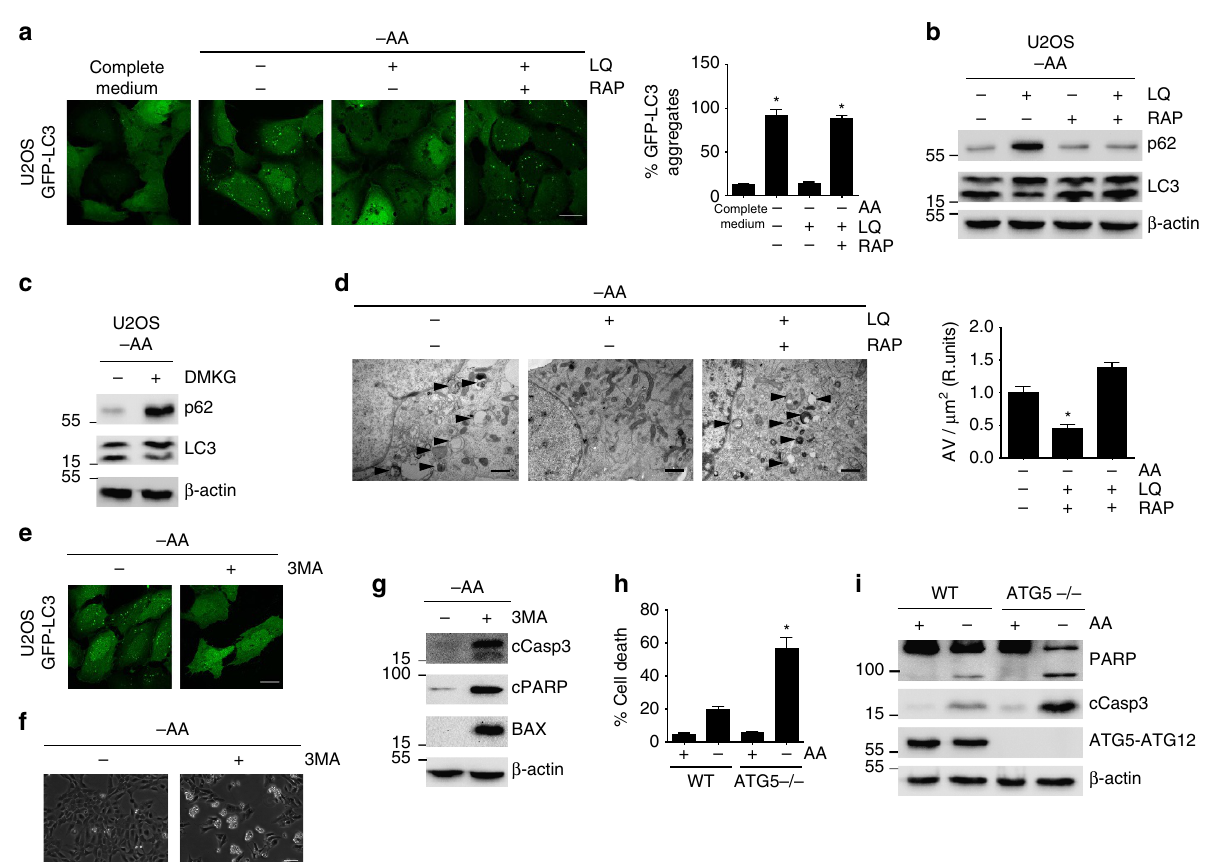
Figure 4 | Glutaminolysis activated cells showed an mTORC1 dependent inhibition of autophagy during amino acid restriction. ( a ) GFP-LC3 expressing U2OS cells were starved for amino acids in the presence or absence of LQ and RAP for 72h as indicated. Autophagosome formation upon GFP-LC3 aggregation was determined (left panel) and quantified (right panel) using confocal microscopy. The scale bar represents 20 m m. ( b , c ) Western blot analysis of U2OS cells treated with LQ, DMKG and RAP as indicated to determine the levels of p62 and LC3II after 72h. ( d ) Transmission electron microscopy (TEM) images of U2OS cells starved for amino acid in the presence or absence of LQ and RAP after 72h. The number of autophagy-related vesicles per m m 2 was quantified for each indicated condition. The scale bar represents 1 m m. ( e ) GFP-LC3 expressing U2OS cells were starved for amino acids in the presence or absence of 3MA (5mM) during 72h. Autophagosome formation upon GFP-LC3 aggregation was determined using confocal microscopy. The scale bar represents 20 m m. ( f , g ) Representative microscopy image ( f ) and western blot analysis of apoptotic markers ( g ) in U2OS cells upon 3MA treatment during 72h as indicated. The scale bar represents 100 m m. ( h , i ) WT and ATG5 (cid:2) / (cid:2) MEFs were incubated either in the presence ( þ AA) or the absence ( (cid:2) AA) of amino acids ( þ AA) for 24h. Cell viability using trypan blue exclusion assay ( h ) and western blot analysis of apoptotic markers ( i ) are shown. Graphs show mean values ± s.e.m. ( n ¼ 3). * P o 0.05 (Anova post hoc